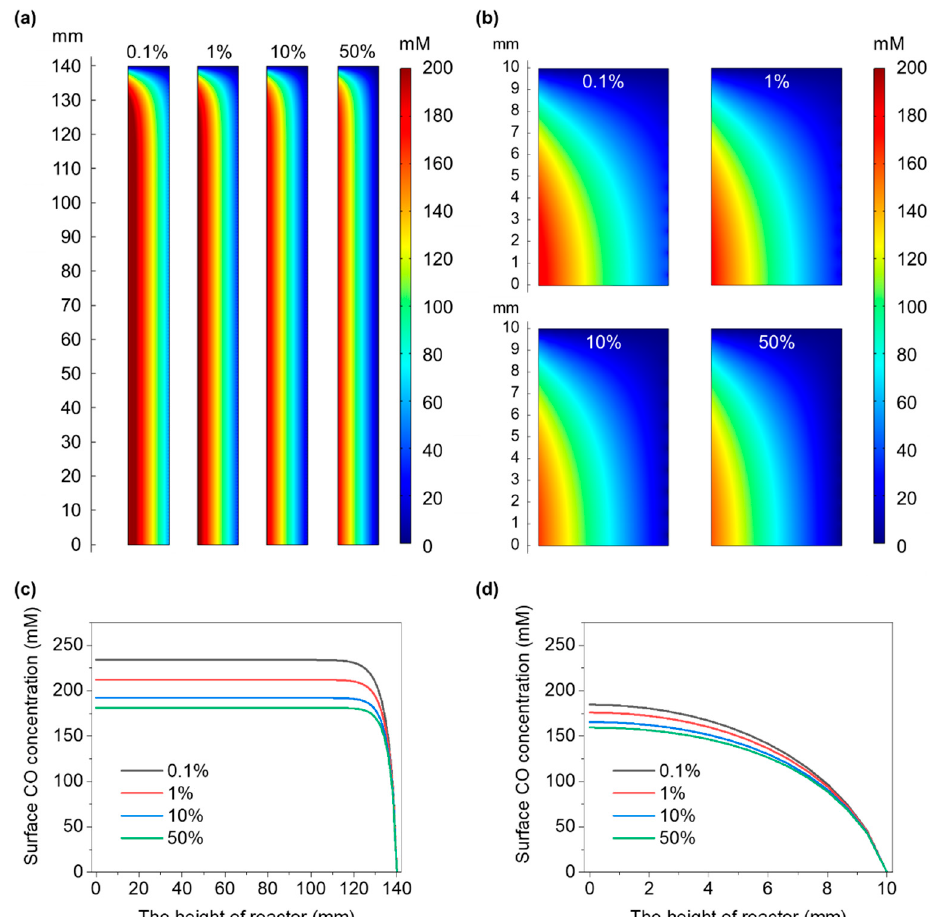
Figure 6. Mass transport modeling. CO concentration contours for the cross-section of the catholyte chamber in ( a ) the big electrochemical cell and ( b ) the small electrochemical cell. The CO 2 bubbles ratio was set at 0.1%, 1%, 10%, and 50%, respectively. The surface CO concentration versus the height of reactor curves in ( c ) the big electrochemical cell and ( d ) the small electrochemical cell.